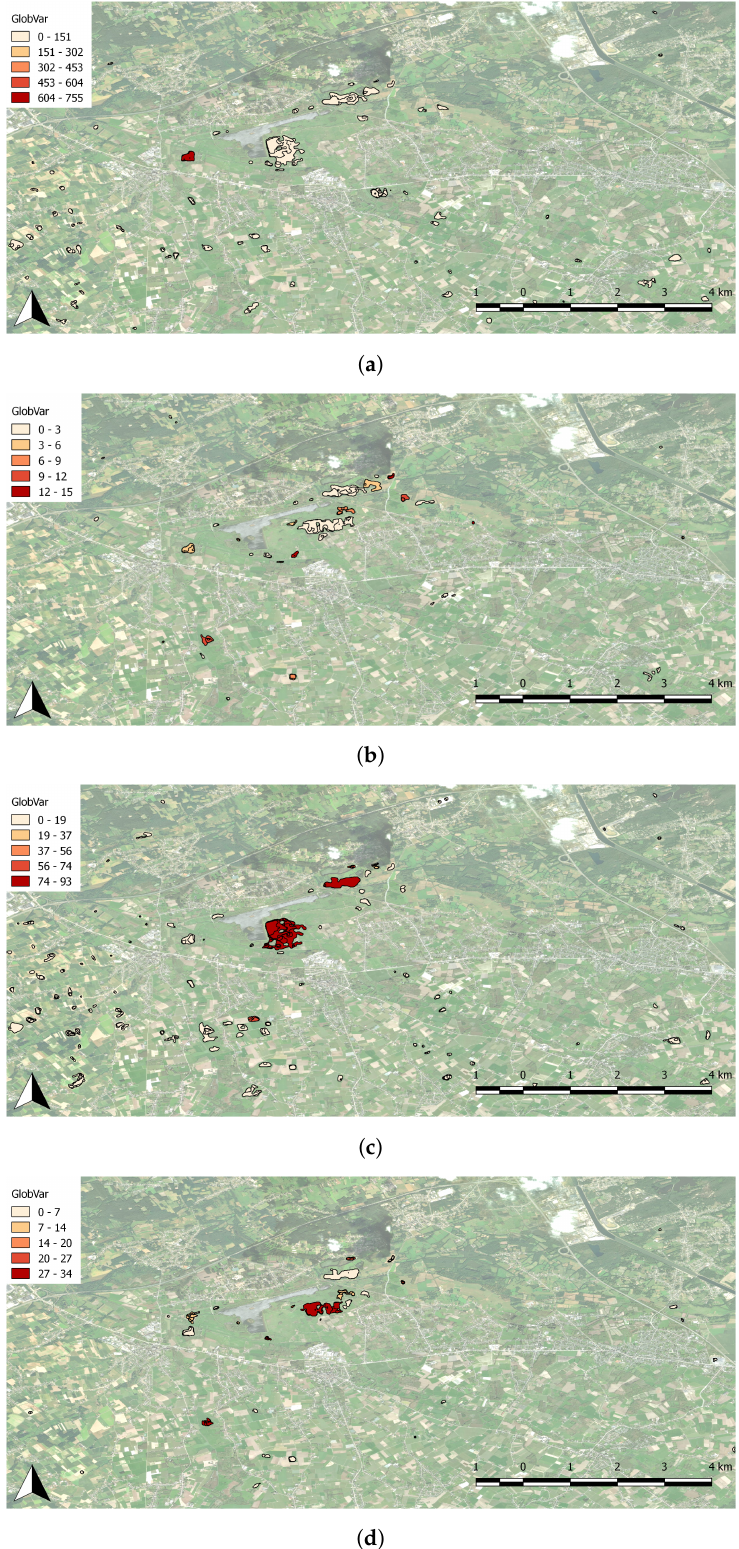
Figure 10. Global variation for temporary entities. ( a ) Ascending time series VV polarisation. ( b ) Ascending time series VH polarisation. ( c ) Descending time series VV polarisation. ( d ) Descending time series VH